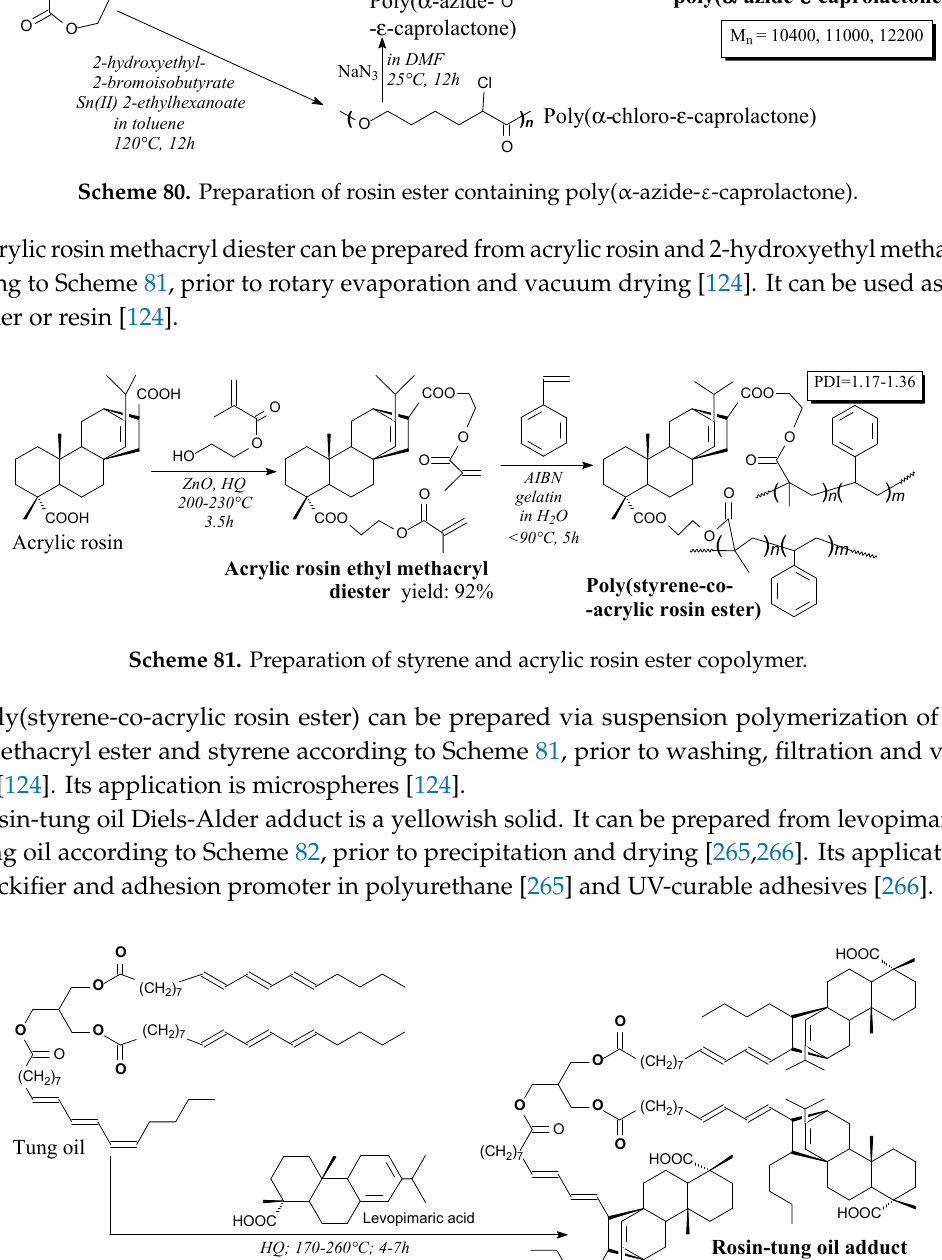
Rosin-tung oil adduct conversion: 72%